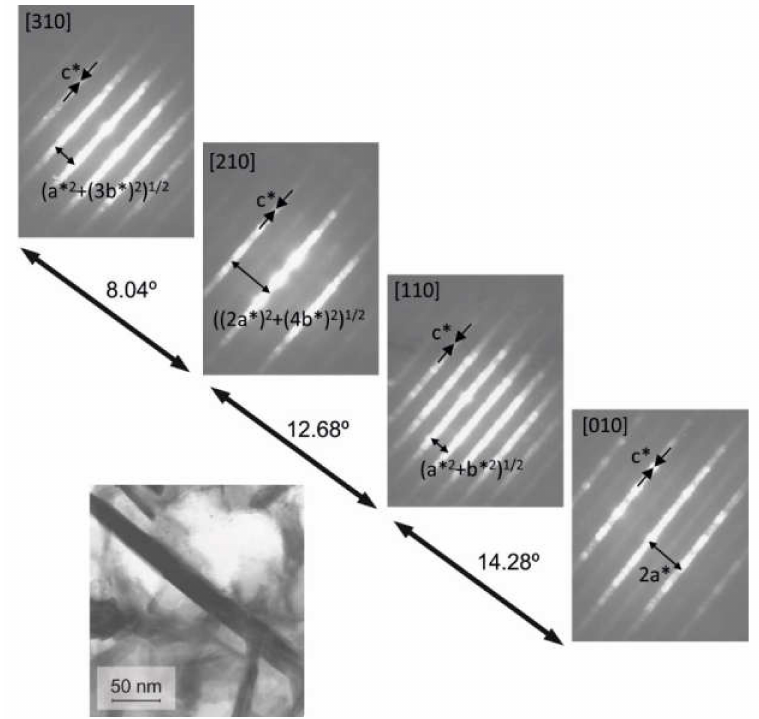
Figure 8. TEM analysis of a metastable intermetallic particle in an Al 87 -Sm 4 -Ni 8 -Cu 1 ribbon treated to 375 ◦ C + 30 min. Angles between patterns and di ff raction spot distances served to index